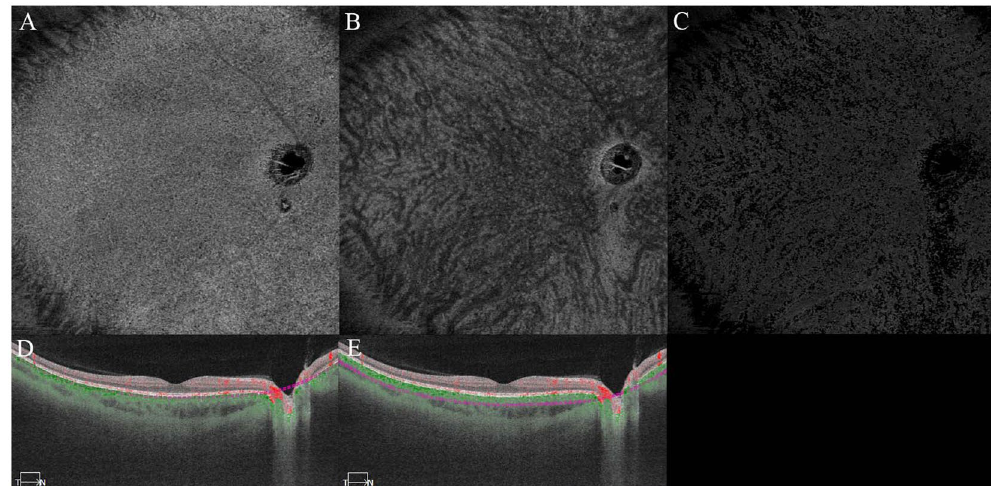
Figure 2. Case 8. Right eye of 43-year-old man. Subfoveal choroidal thickness is 430 µ m. Ratio of flow area is 50.1%. Brightness and contrast are adjusted for easier observations of the figures. ( A ) Choriocapillaris image. ( B ) Half of the choroid image. ( C ) Choroidal blood flow image after removal of the projection artifacts of choriocapillaris. ( D ) Cross sectional image with the segmentation boundaries set to the choriocapillaris. ( E ) Cross sectional image with the segmentation boundaries set to one-half of the choroid.